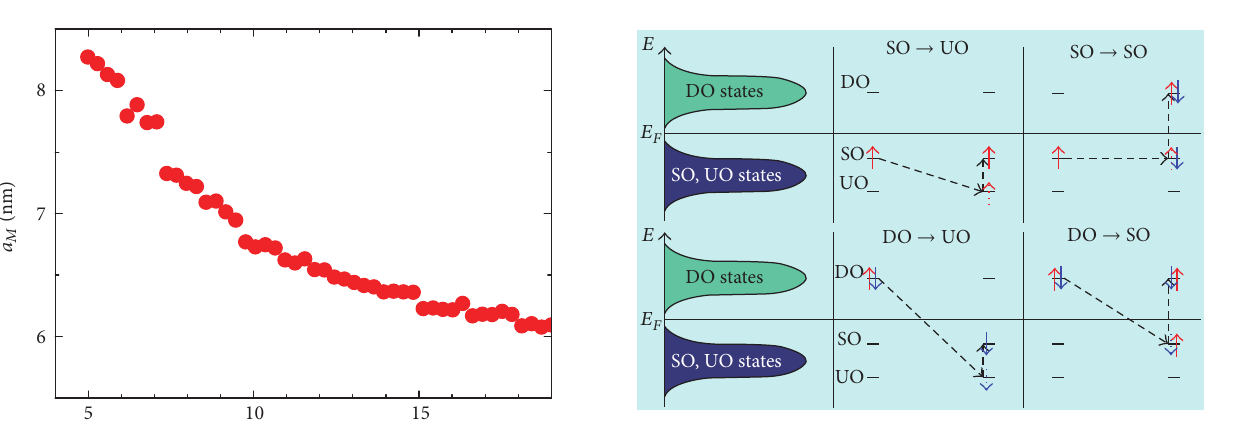
Figure 6: Possible electron hops considered for low temperature conductivity. For more details, see the